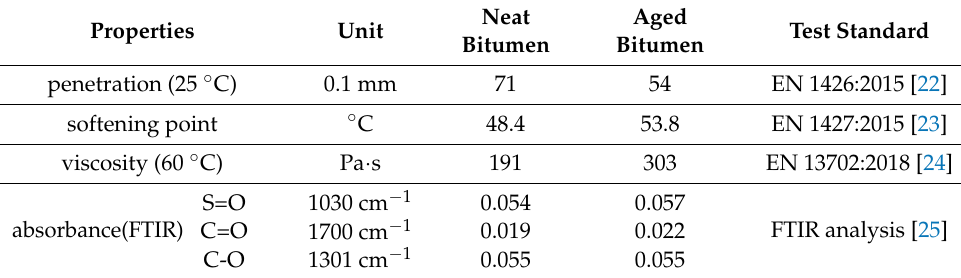
Table 1. The physical and chemical properties of the